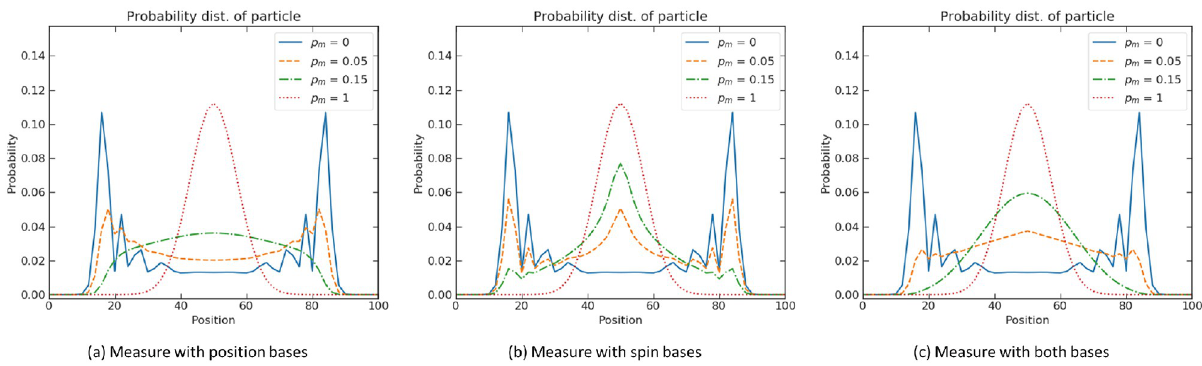
Fig 5. Position probability distribution with different levels of decoherence p (c) Measurement in both spaces. Parameters are ρ = 0.5, η = 0.5, ξ = 0, step sizes s L = s R = 1 at time t = 50 in an unbounded position space.